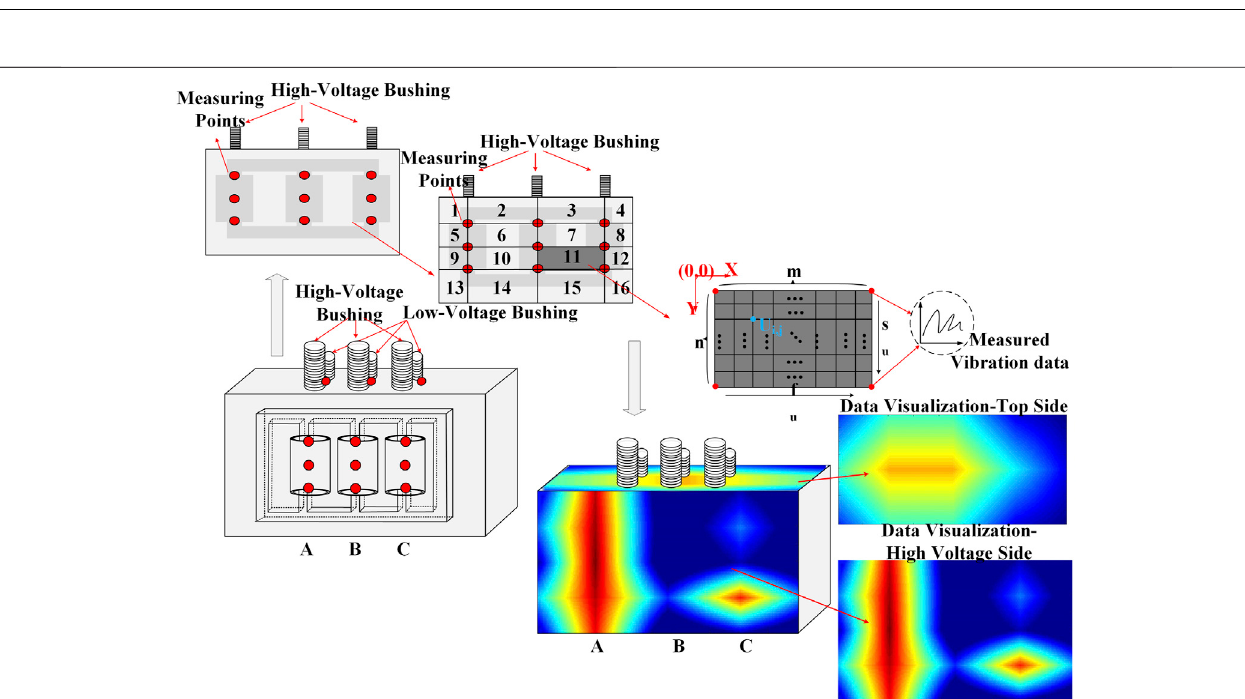
FIGURE 6 | Data mapping and visualization of transformer vibration.